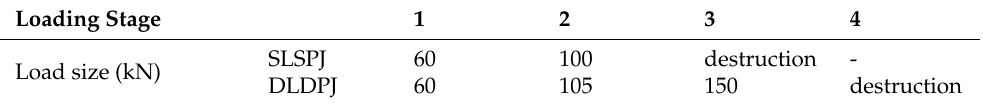
Table 1. Load classifications of the specimens of SLSPJ and